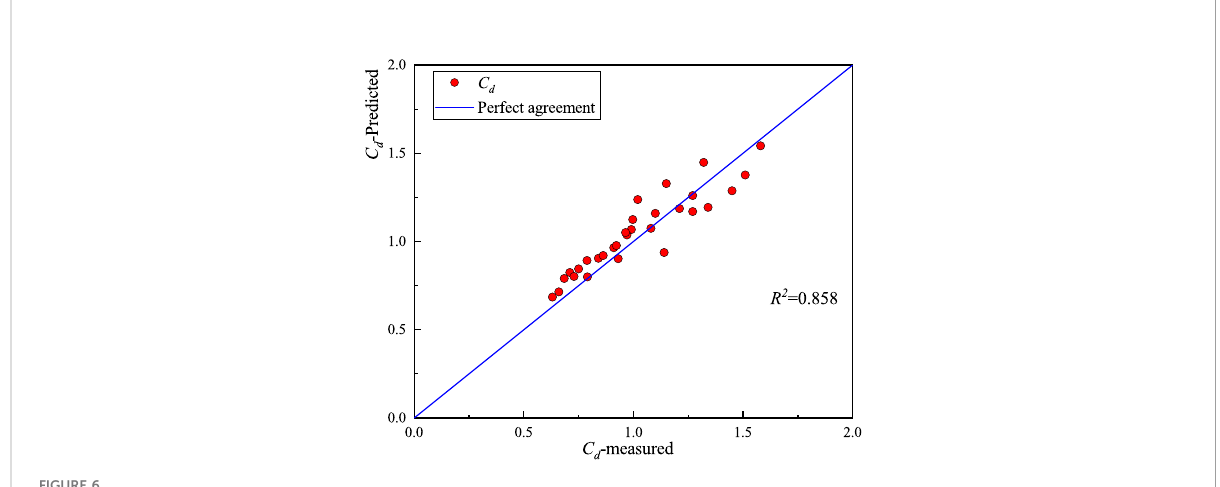
FIGURE 6 A comparison of the predicted and measured values of bulk drag coef fi cient, C d , under different test